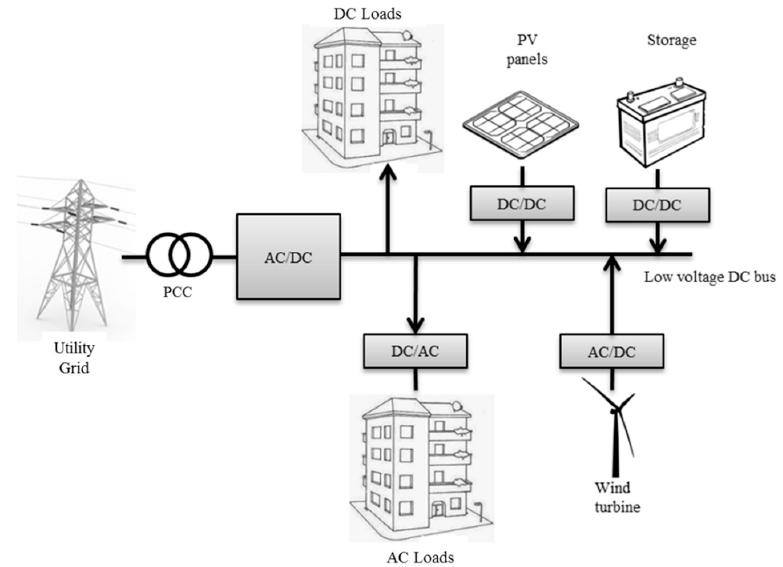
Figure 1. General DC microgrid architecture.